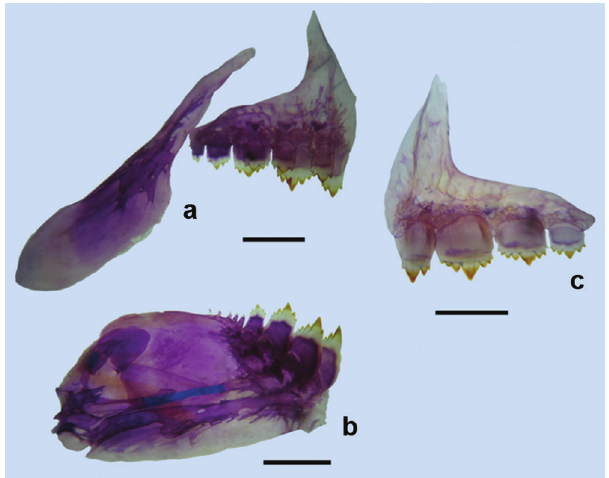
Fig. 2. Astyanax powelli , paratype CI-FML 6798. a. 57.6 mm SL, maxilla and premaxilla. b. Dentary, lateral view, anterior to right. c. 45.7 mm SL, premaxilla, medial view, anterior to left. Scale bars = 1